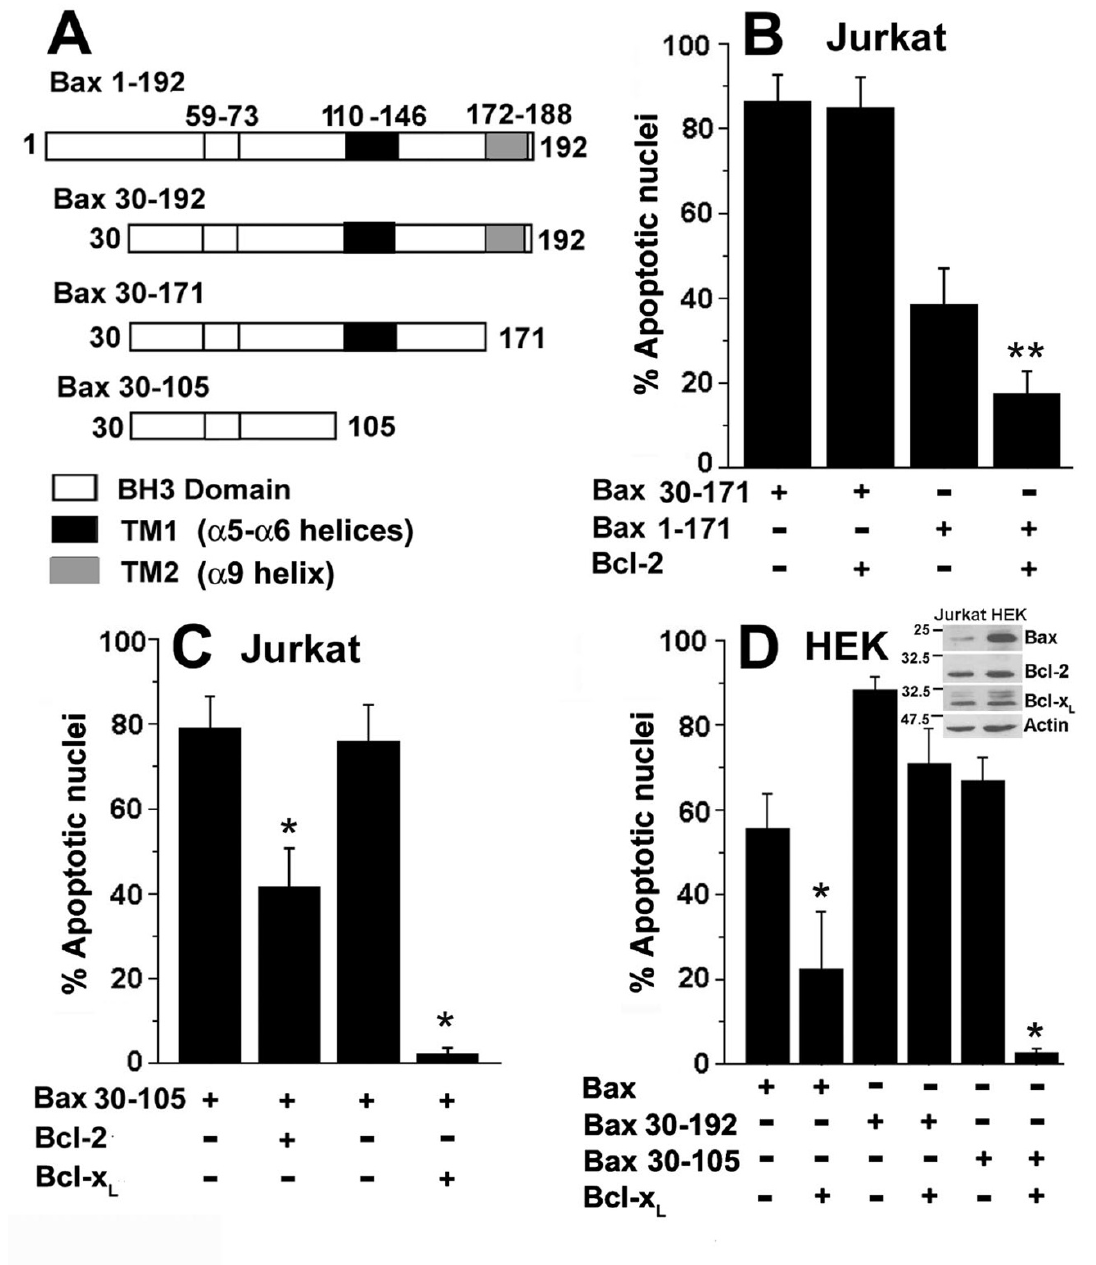
Figure 3 Apoptosis triggered by TM deletion mutants is inhibited by Bcl-x Bax constructs used in functional assays. The numerals indicate the amino acid residue number in the Bax protein (192 amino acids). TM1: transmembrane domain 1, TM2: transmembrane domain 2. B-D, Apoptotic nuclear damage in cells assessed 12–15 hours post-transfection in B, Jurkat cells transfected with GFP, Bax 30–171-GFP or Bax 1–171-GFP with or without Bcl-2 as indicated. The data in the figure is normalized to nuclear damage in GFP or GFP + Bcl-2 transfected cells. C, Jurkat cells trans- fected with GFP, Bax 30–105-GFP (3 μ g) with Bcl-2 (3 μ g) or Bcl-x 30–192-GFP (1 μ g) or Bax 30–105-GFP (1 μ g) with or without Bcl-x determined by western blot analysis of the Jurkat and HEK cell lines. The data are presented as mean ± SD derived from a min- imum of three independent experiments. **p < 0.01; *p <